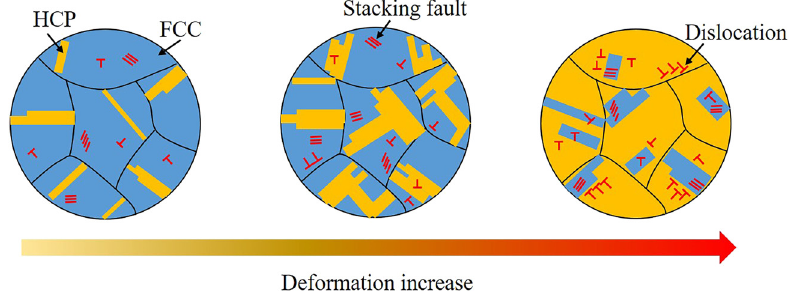
Figure 9: Schematic diagram of phase transition of the TRIP - DP -